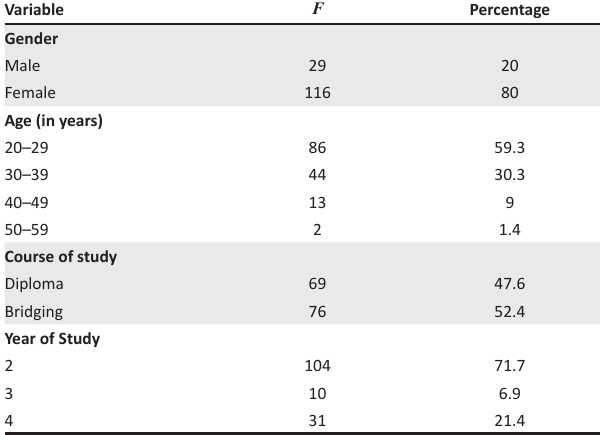
TABLE 1: Demographic profile ( n =